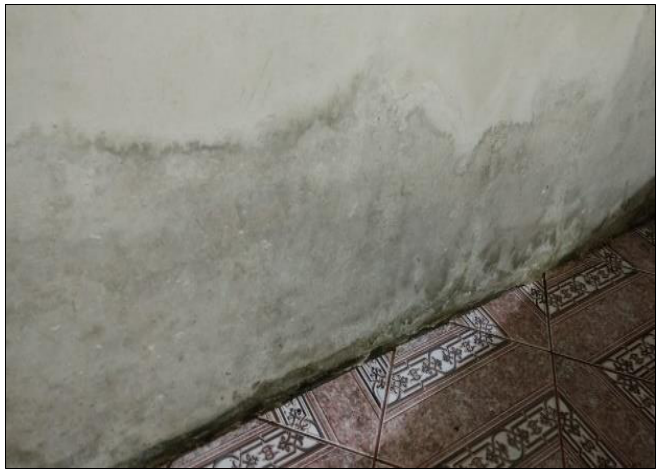
Figure 1: Wall with pathology caused by